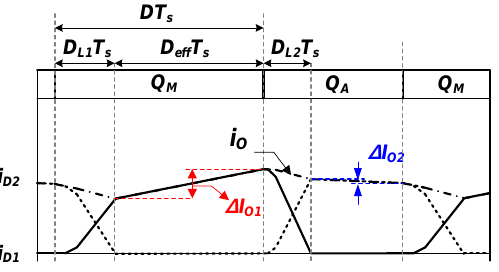
Figure 7. Primary and secondary current waveforms of the proposed converter without dead- time.